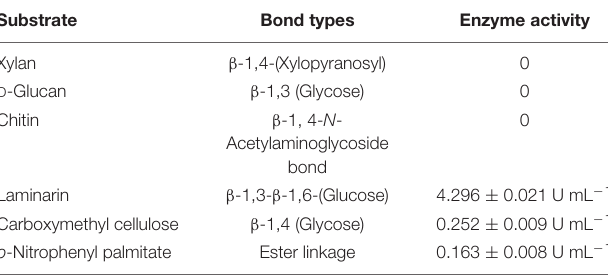
TABLE 1 | Substrate specificity of extracellular crude enzymes of strain R31. Substrate Bond types Enzyme